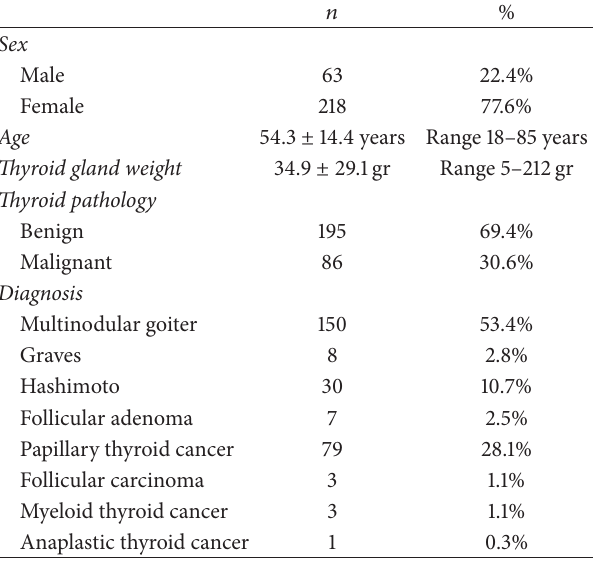
Table 1: Demographic and pathological